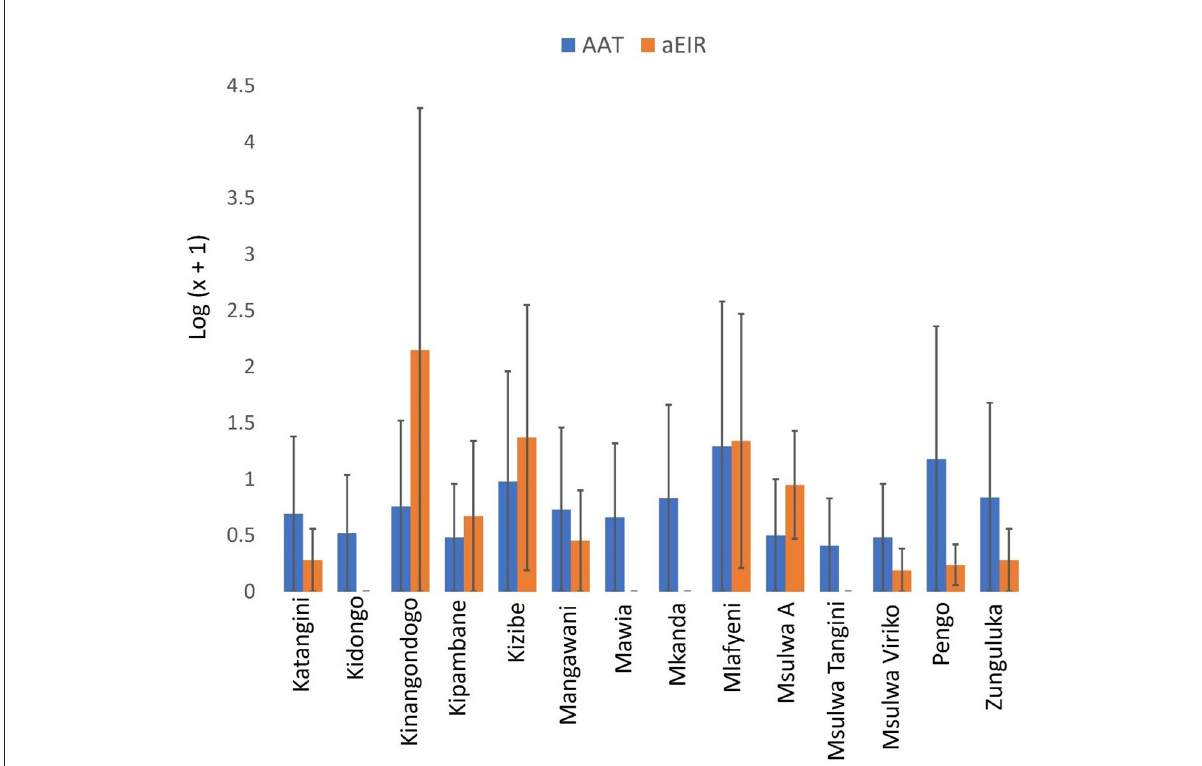
FIGURE11 Annual EIR of tsetse flies and trypanosome parasitological rates in cattle. Error bars are used to indicate the standard error of the mean